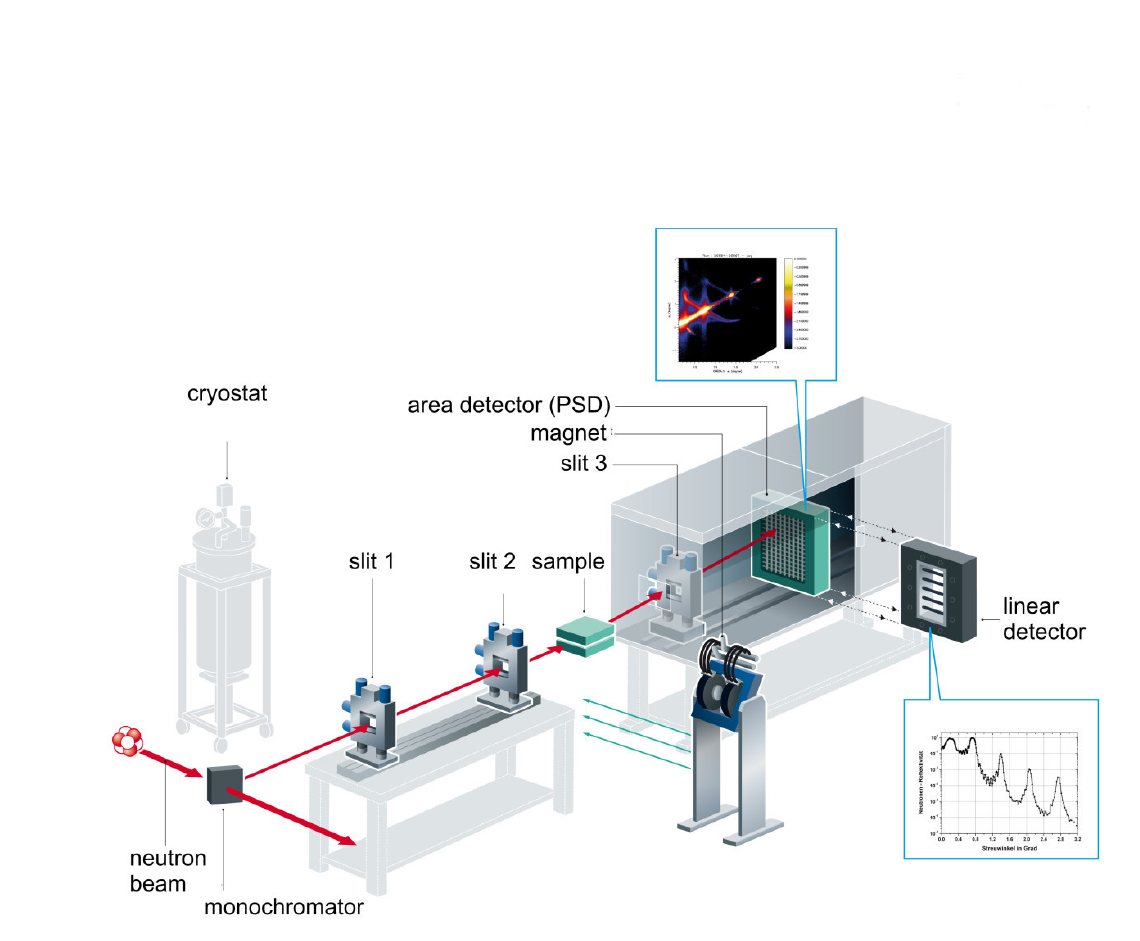
Figure 2: Schematic view of